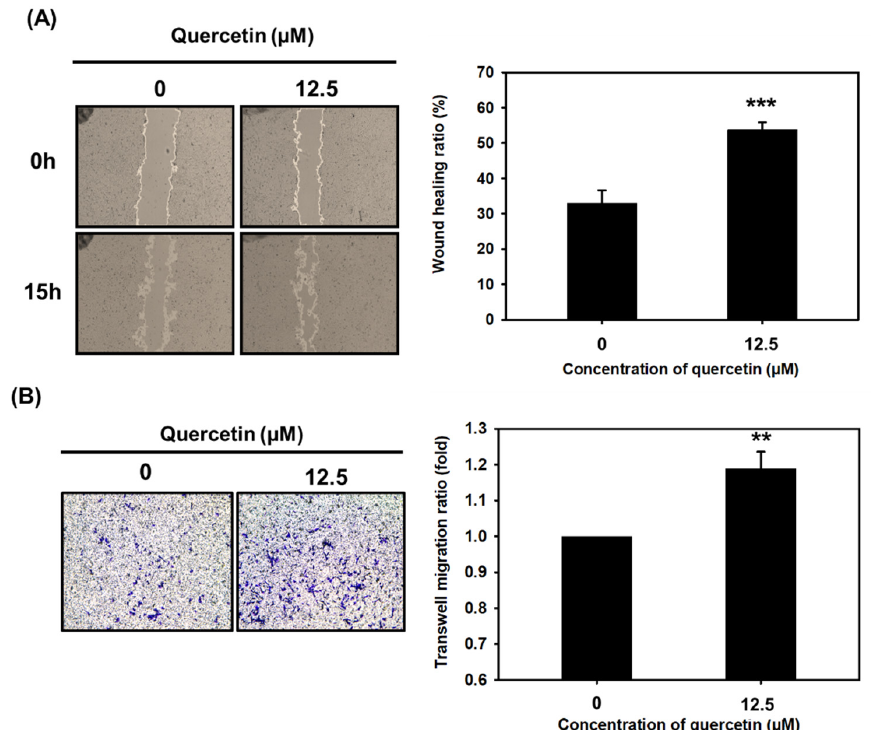
Figure 4. Quercetin significantly increased myoblast migration compared to controls. Wound-healing and transwell migration assays were used to study C2C12 cell migration. C2C12 cells were treated with quercetin (0, 12.5 µ M) and cultured in DMEM medium containing 2% horse serum for 15 h. ( A ) Image J was used to measure the wound-healing ratio, and the bar graph shows the percentage of closure compared to controls after 15 h. ( B ) Transwell migration assay was conducted in a transwell chamber, and optical density was observed and quantified using crystal violet staining at 595 nm. Bar graph shows percentage staining. For both assays, data are expressed as mean ± SD based on three independent biological repeats ( n = 3). The differences were significant, *** p < 0.001 and ** p < 0.01, respectively.